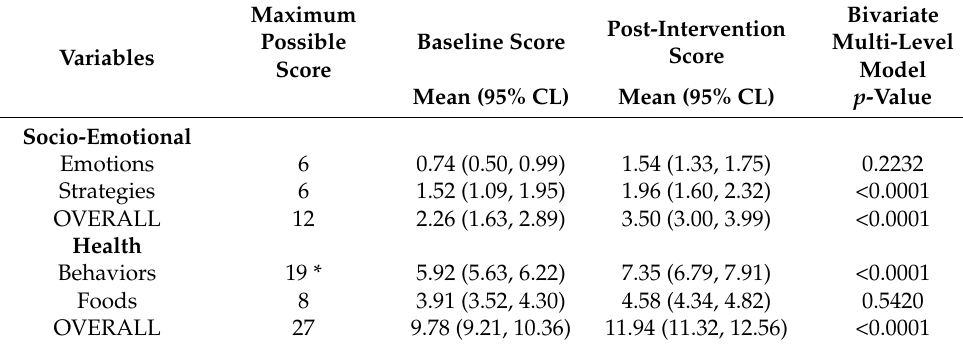
Table 2. Baseline and post-intervention measures.